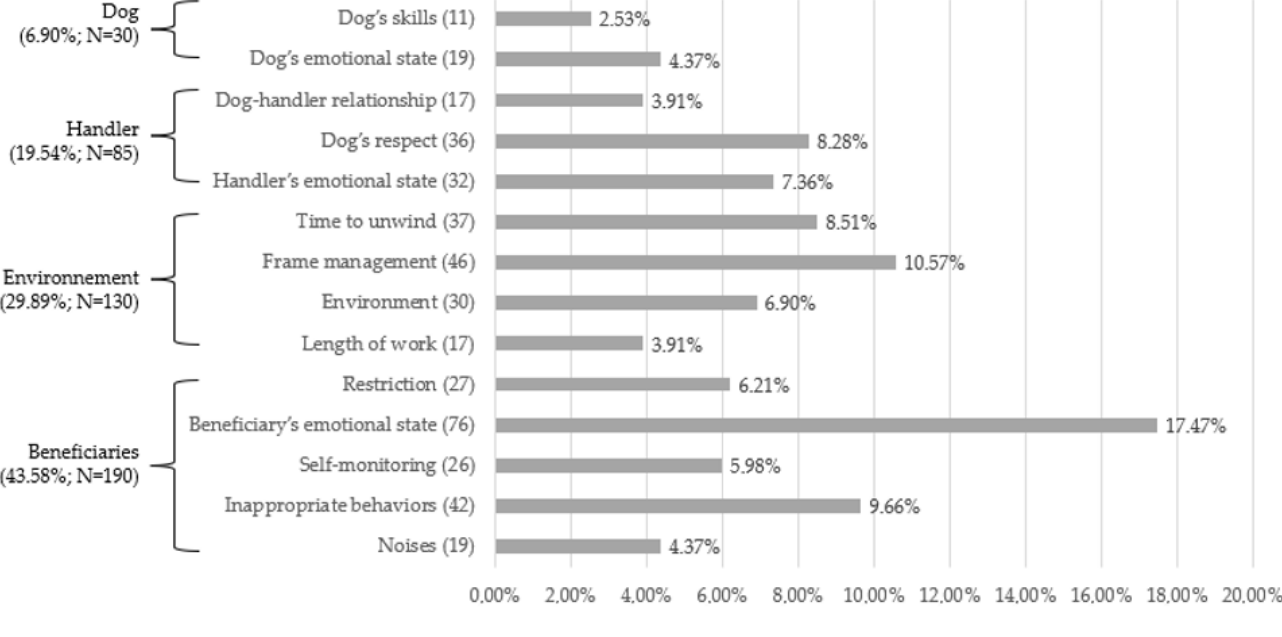
Figure 1. This figure represents the factors identified by 111 handlers as parameters that can impact therapy dog welfare. n = 435 themes categorized in 14 themes. Values are indicated next to the theme in brackets.